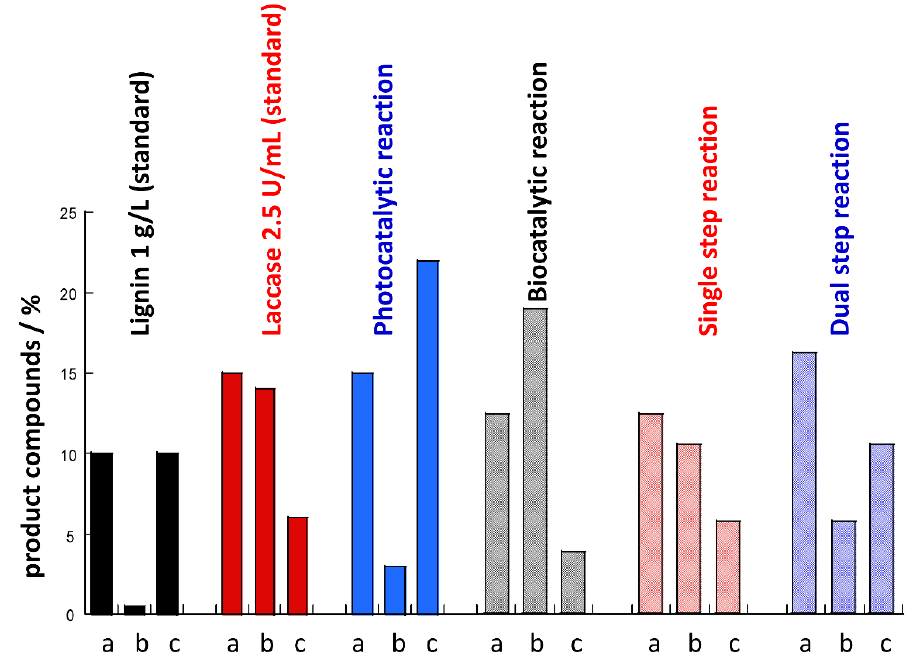
Figure 17. The percentage of intermediate compounds from lignin—(a) fatty acids, (b) carbohy- drates, and (c) organic acids—from experiments conducted in the absence of H 2 O [140] Adapted with permission from American Chemical Society, Energy & Fuels , Kamwilaisak, K., Wright, P.C., Copyright 2012. Table 4. Summary of results of the photocatalytic conversion of lignin and its